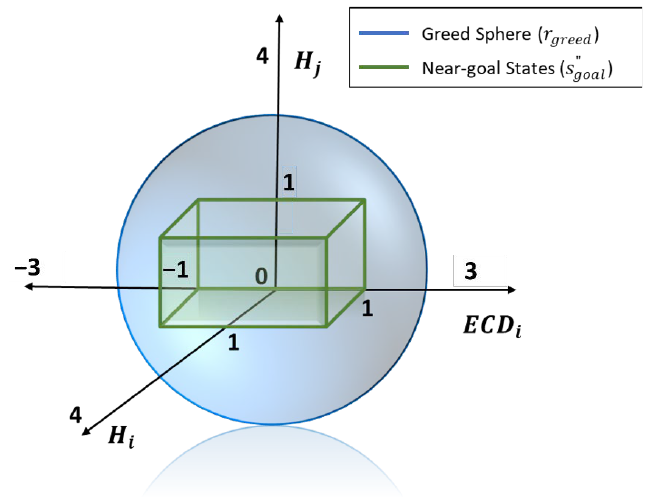
Figure 10. Method for estimating the action set associated with sequential metric. Numbers on axes are in control variable value units.